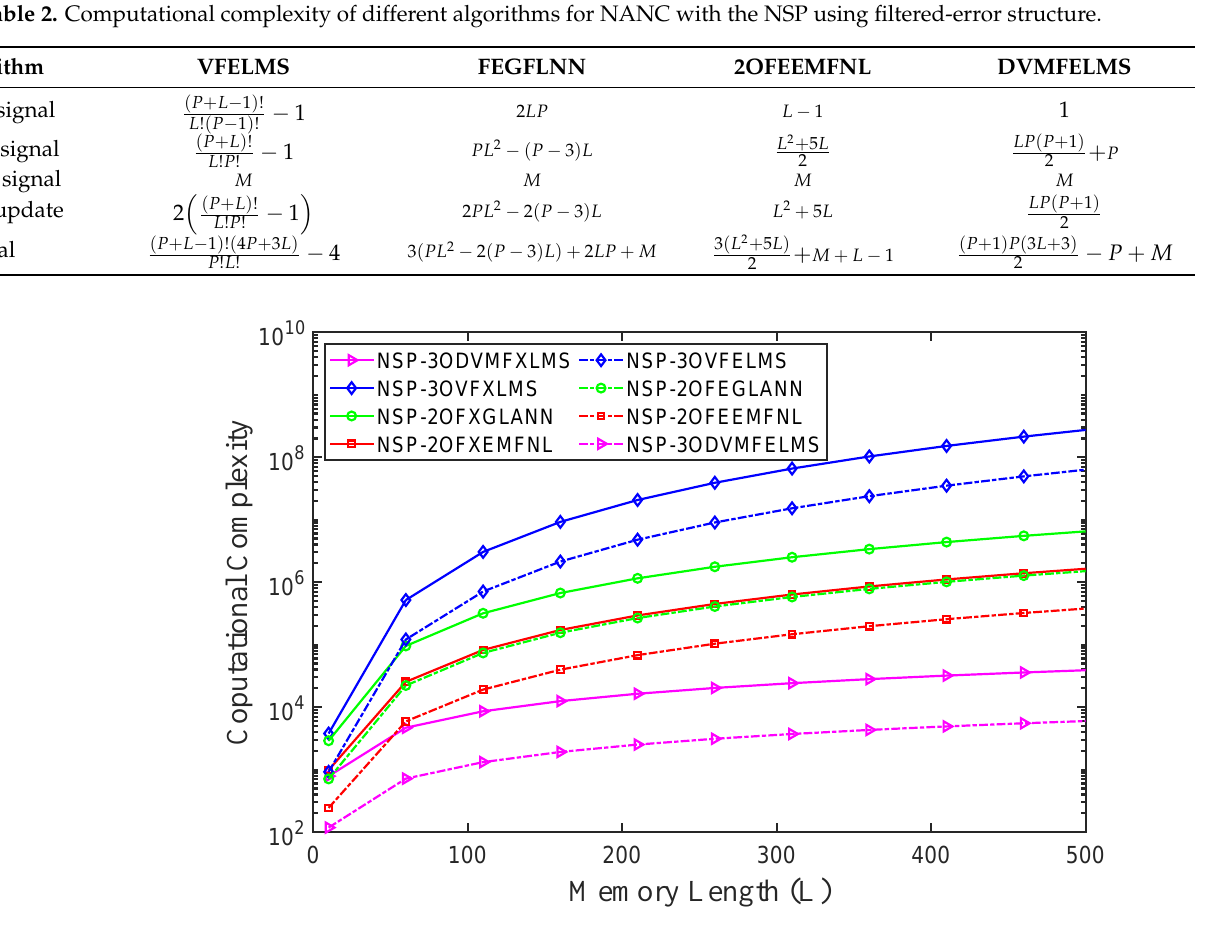
Figure 3. Number of multiplications versus memory